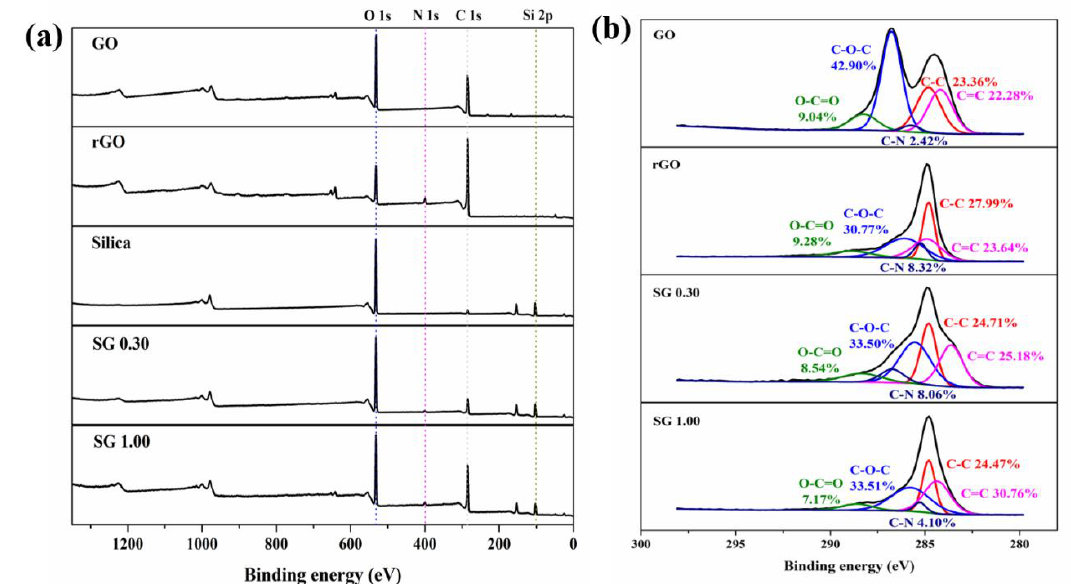
Figure 5. ( a ) XPS survey spectra of GO, rGO, silica, SG 0.30, and SG 1.00 and ( b ) XPS C 1s spectra of GO, rGO, SG 0.30, and SG 1.00.